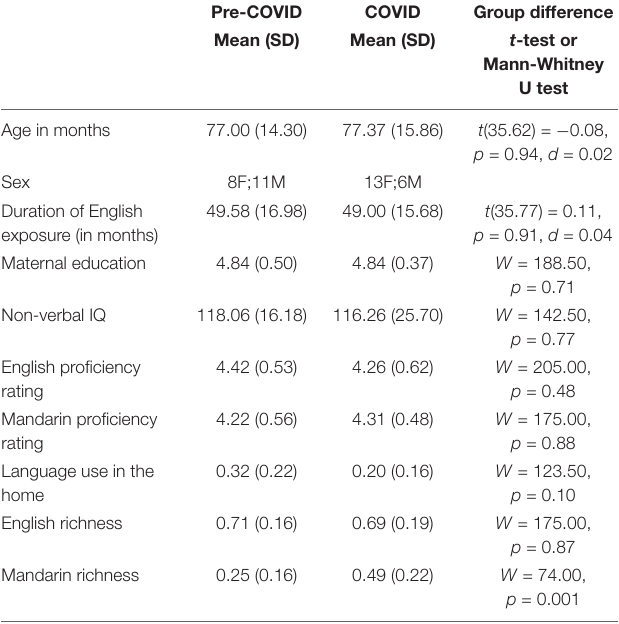
TABLE 1 | Participant information and language